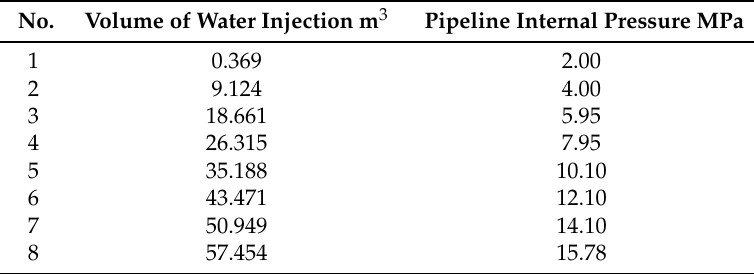
Table 3. The pressure–volume